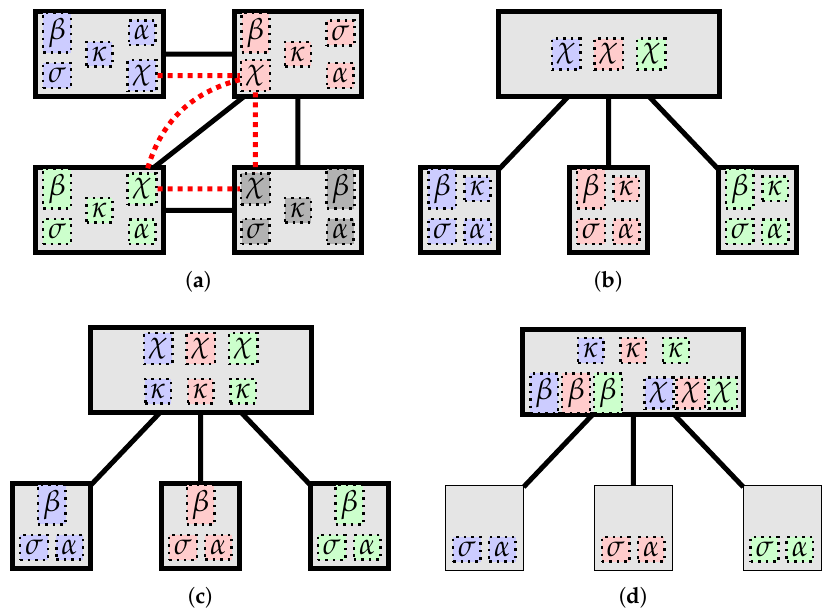
Figure 4. Examples of notable deployments. Refer to Figure 3 for a legend of the graphical symbols. ( a ) Peer-to-peer style; ( b ) Broker-based, as found in IoT publish/subscribe protocols (e.g., MQTT); ( c ) Big data in the cloud; ( d ) Thin hosts with only